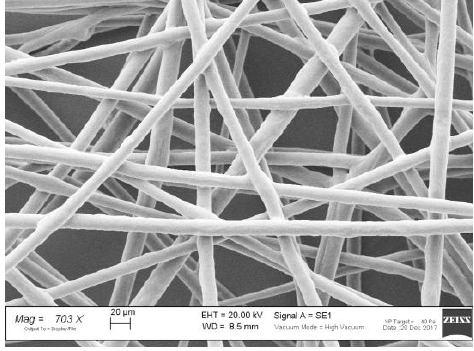
Figure 1. SEM micrograph of ALG/h-PEO fibers.